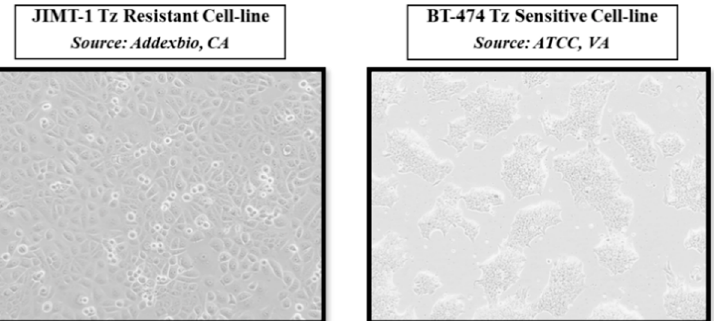
Figure 1. Original morphology of Se ‐ Trastuzumab treated JIMT ‐ 1, Trastuzumab resistant and BT ‐ 474, Trastuzumab sensitive cell lines. Doubling cell division times for JIMT ‐ 1 and BT ‐ 474 cells were approximately 30 and 100 h, respectively.